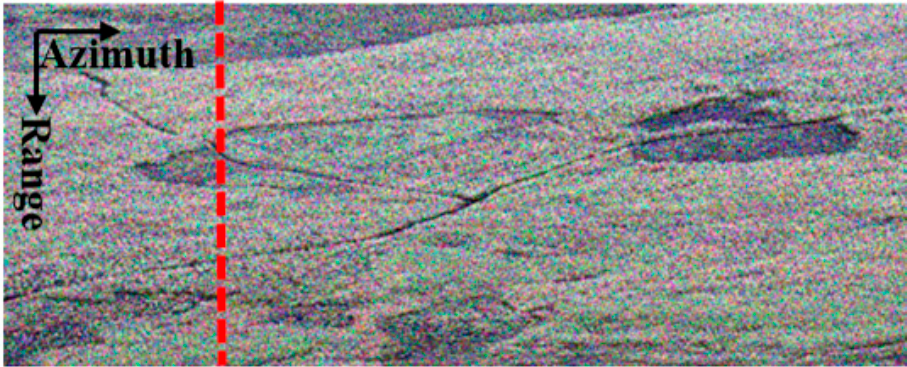
Figure 6. The selected azimuth profile (red dotted line) on the SAR intensity